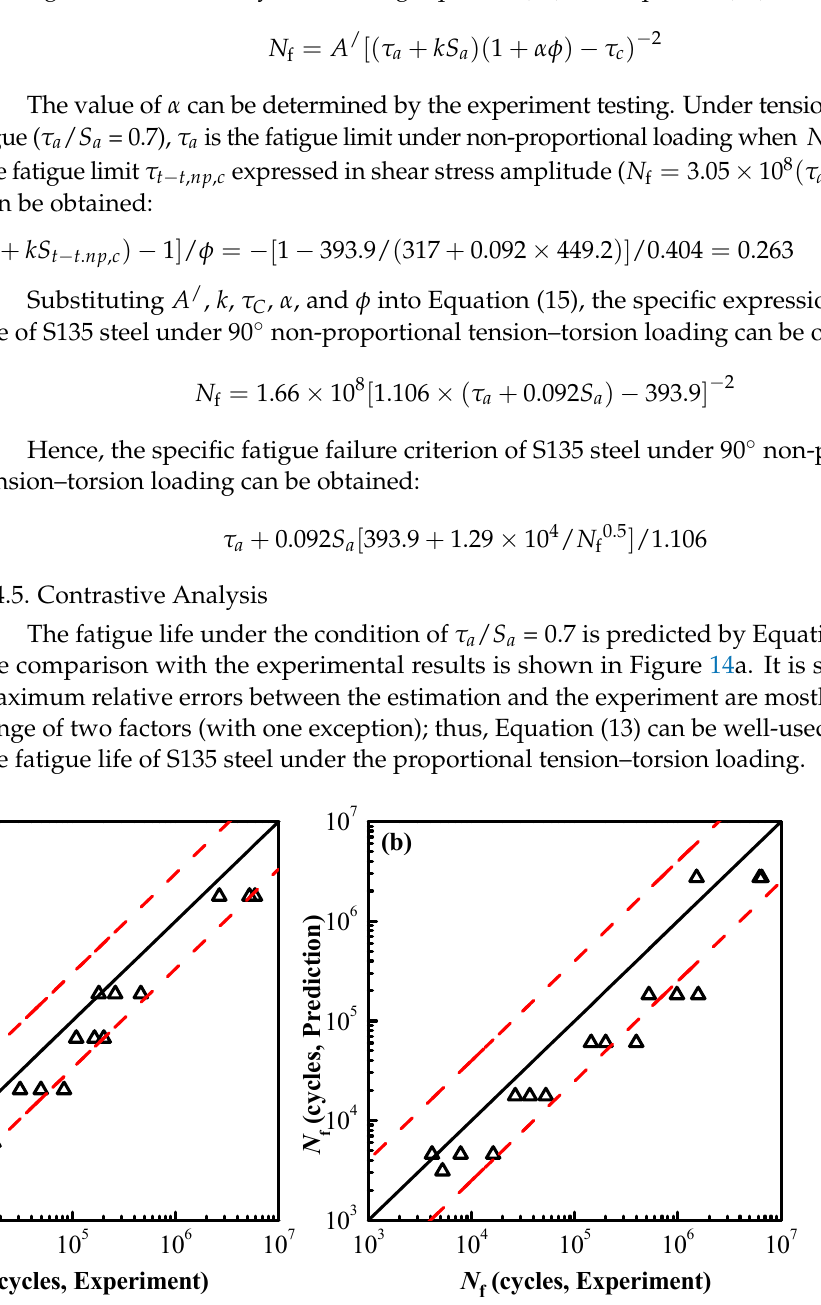
Figure 14. Predicted versus experimental live under proportional loading ( a ) and non-proportional loading ( b ).